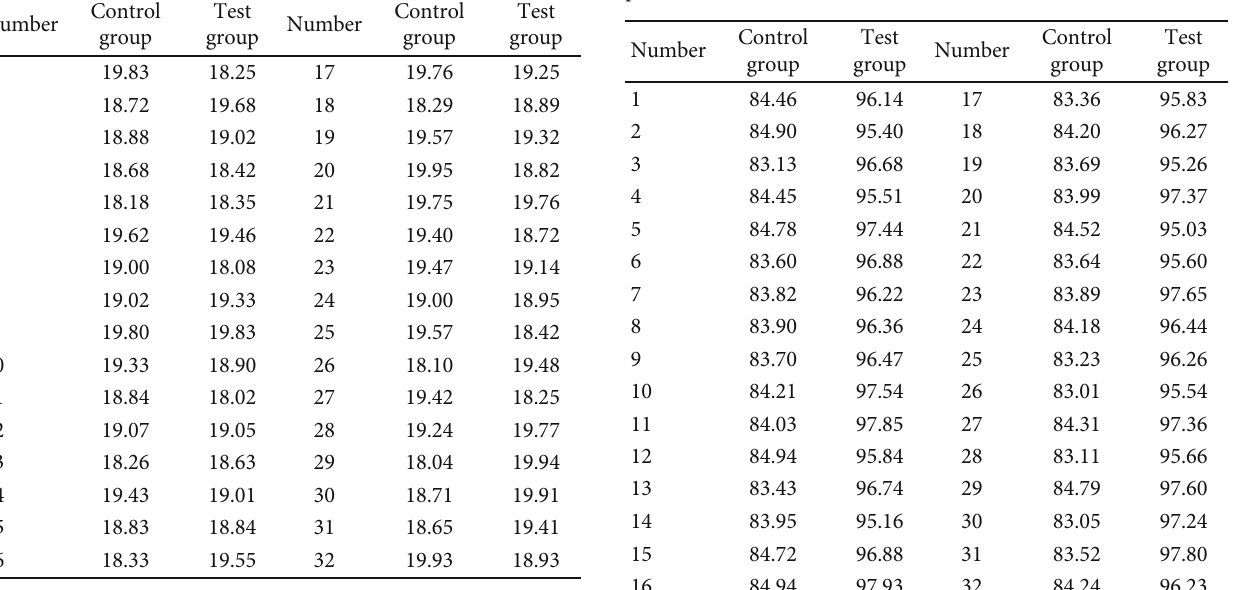
Table 3: Comparison of the overall e ffi cacy of the two groups of